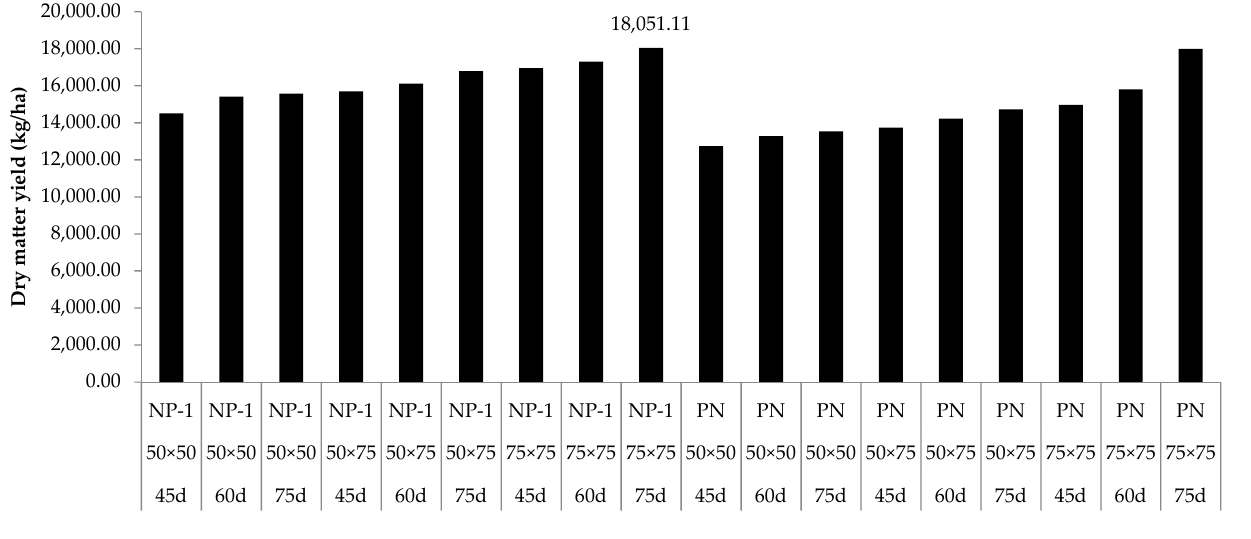
Figure 1. Dry matter yield (kg/ha) of fresh Napier grass as affected by cultivar × plant spacing (cm 2 ) × harvesting age (days). Cultivar = the cultivar of Napier grass; space = plant spacing (cm 2 ); age = harvesting age (days); NP-1 = Napier Pakchong 1 grass; PN = purple Napier grass.